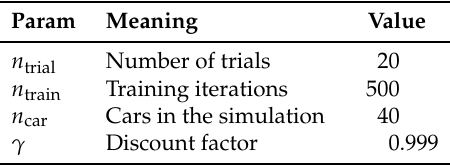
Table 2. Policy learning algorithm parameters.